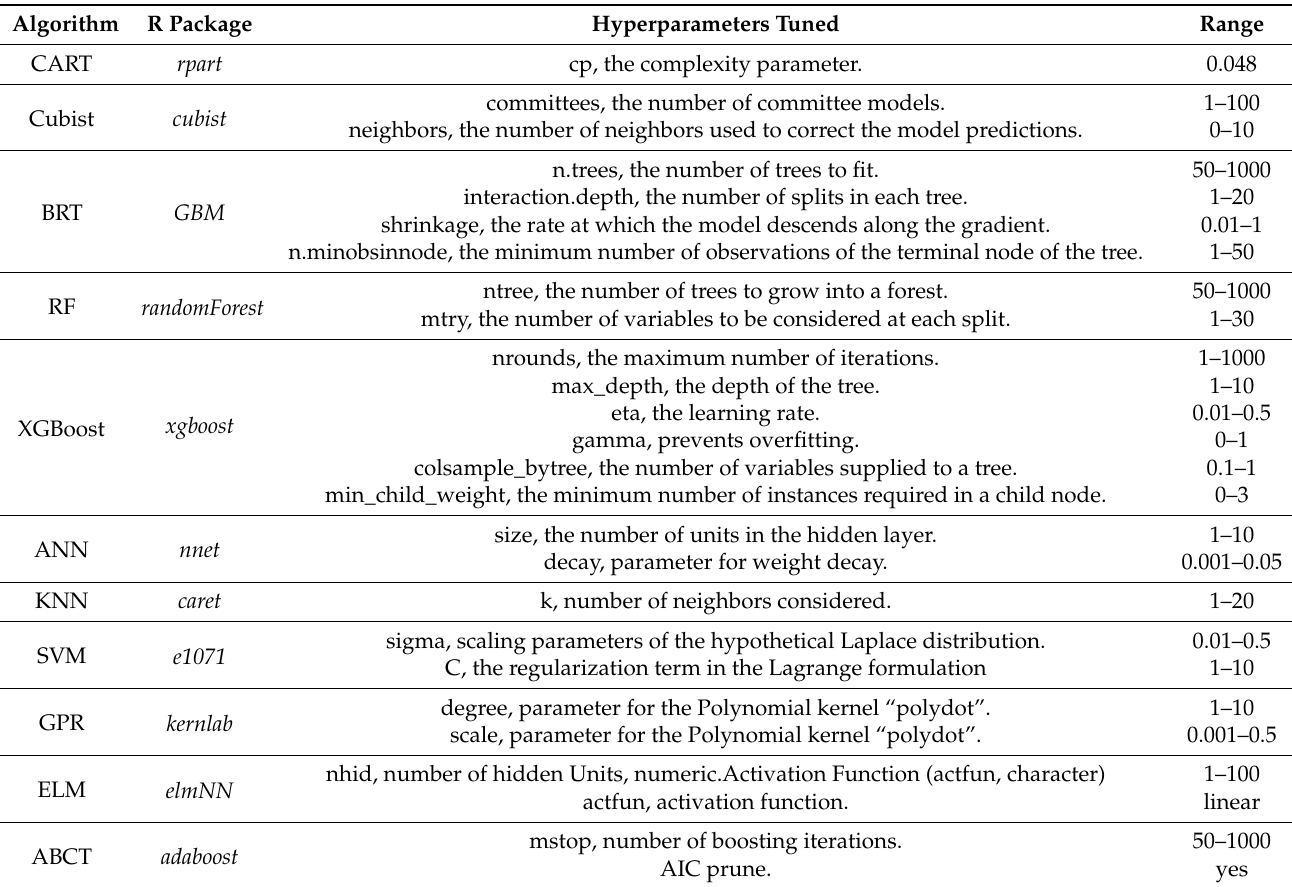
Table 3. Hyperparameters tuned and their configurations for each